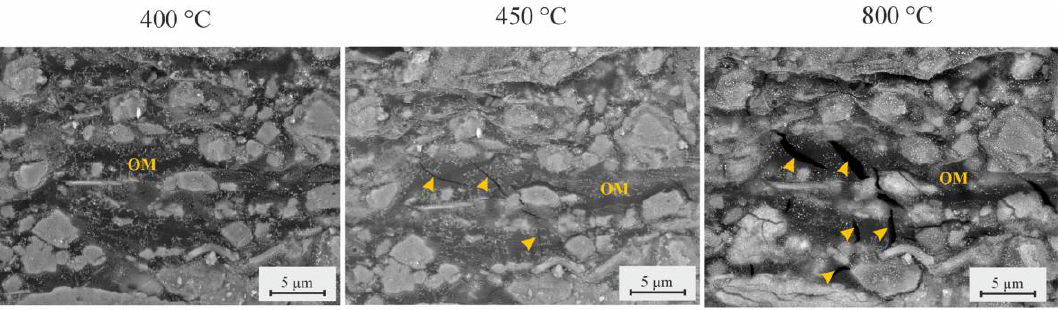
Figure 8. t at T = 400, 450, and 800 °C. The appearance of fractures in kerogen at T = 400 °C is shown; the fracture aperture increased with temperature. OM — organic matter; yellow arrows — fractures.